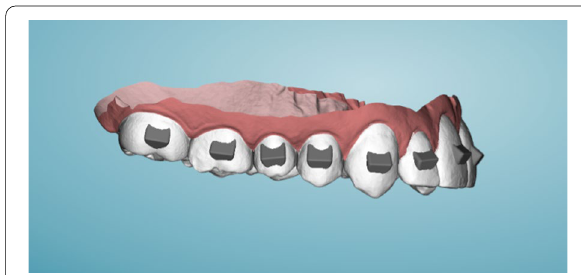
Fig. 1 Design of the YA Master Model with attachments as designed in